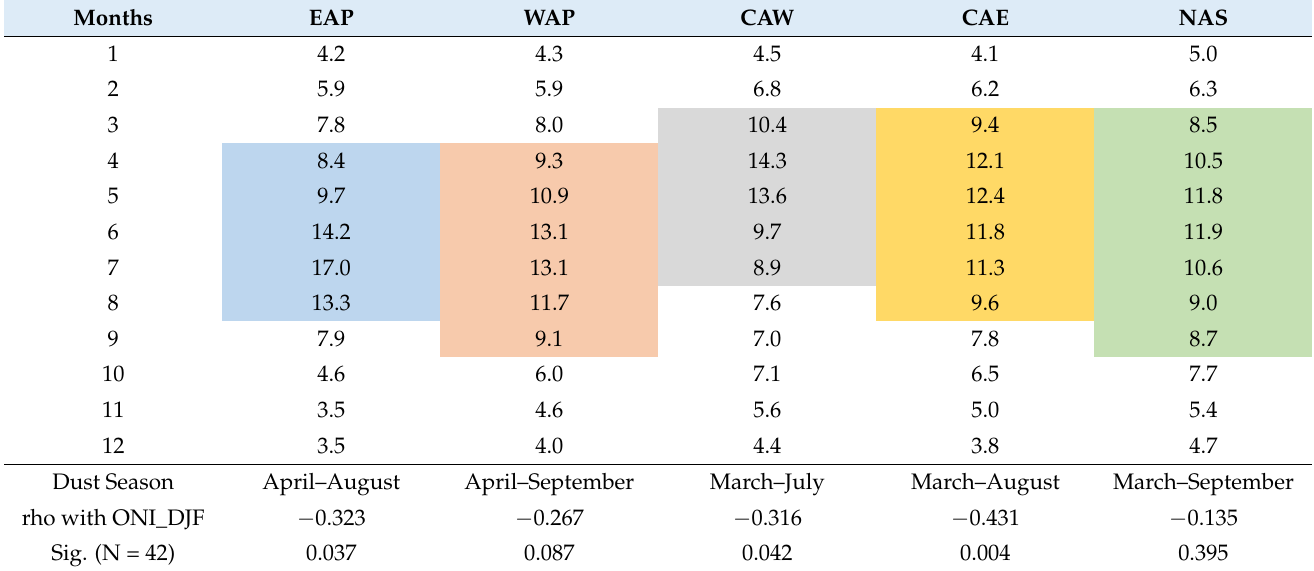
Figure 4. Mean dust column mass density values (unit: kg m −2 ) by 3-month periods throughout the year during 1980 – 2021 for the four subregions and North Africa – Sahara (NAS) for comparison. The error bars represent the standard deviations of individual months of the year. Table 2. Mean percentage of monthly dust mass density relative to the annual totals in the subregions. The color shaded cells represent the respective dust seasons, which are arbitrarily determined as the months when the monthly relative contribution is higher than 8.33% (100% divided by 12 months). Additionally included are the Spearman’s rank correlations between the dust–season mean series and ONI_DJF during 1980 – 2021.